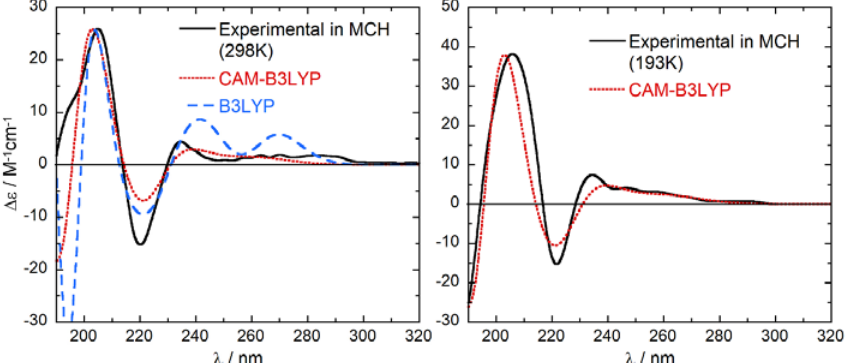
Figure 5. Comparison between experimental ECD spectra of ( R )- 1 measured in MCH at 298 K (left) and 183 K (right) and ECD spectra calculated at CAM-B3LYP/def2-TZVP and B3LYP/def2-TZVP levels as Boltzmann-weighted averages estimated from ω B97X-D/6-31+G(d) energies at the respective temperatures. Spectra plotted as sum of Gaussians with σ = 0.3 eV, shifted by +13 nm, scaling factor 0.31 (CAM-B3LYP); σ = 0.22 eV, shifted by +6 nm, scaling factor 0.6 (B3LYP).